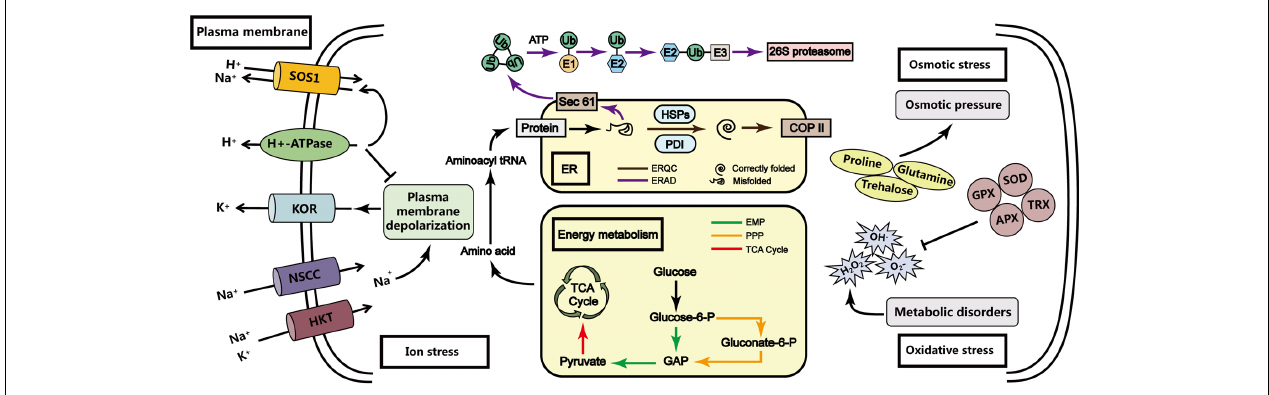
FIGURE 9 | Model of the P. haitanensis response mechanism under hypersaline stress. Previous research indicated that under hypersaline stress, P. haitanensis is primarily subjected to ion stress, osmotic stress, and oxidative stress. However, P. haitanensis can respond to hypersaline stress via the transmembrane transport of Na + (Na + /H + antiporter and H + -ATPase), the synthesis or accumulation of available osmotic substances (e.g., proline and trehalose), and increases in the content or activity of antioxidant enzymes (e.g., superoxide dismutase and ascorbate peroxidase) (Chen et al., 2019; Wang et al., 2019). Finally, a new steady-state equilibrium is established to ensure that the algal bodies can survive and perform certain functions under hypersaline stress. Additionally, the P. haitanensis response mechanism under hypersaline conditions is linked to energy metabolism and protein processing. The results of this study imply that under hypersaline stress, P. haitanensis thalli can regulate the EMP pathway and the PPP to provide substrates for the TCA cycle, and enhance the folding and clearing ability of the unfolded proteins. The protein synthesis can provide the energy and components required for physiological and biochemical reactions in P. haitanensis exposed to hypersaline stress.